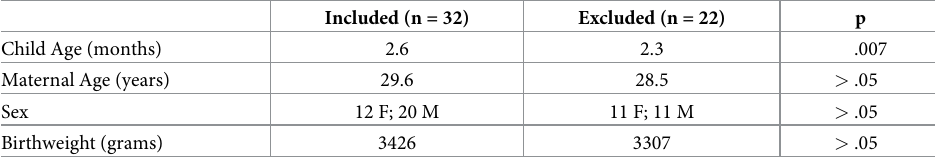
Table 1. Demographic information for included and excluded